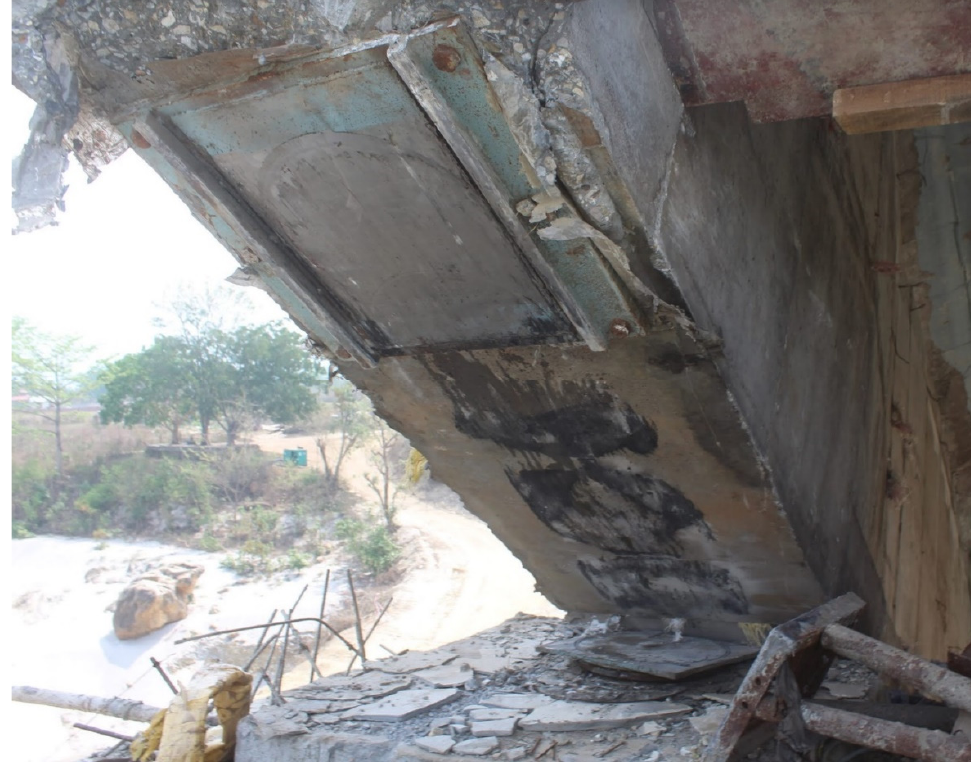
Figure 16. Span-1 deck (over Pier-1) that slid about 1 m towards Pier-1 indicating drag of deck (shown by bearing mark under the beam surface) and damage of bearing.